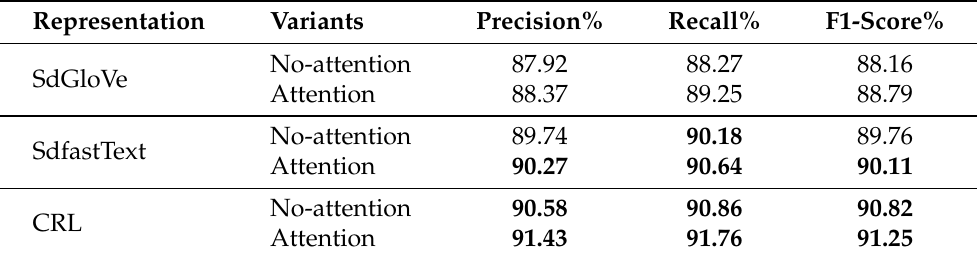
Figure 3. The performance of the CaBiLSTM model with different dropout rates and context settings ( CWS ) on the SiNER development set. Table 7. The results of the proposed CaBiLSTM network on the SiNER test set. Bold font denotes the best